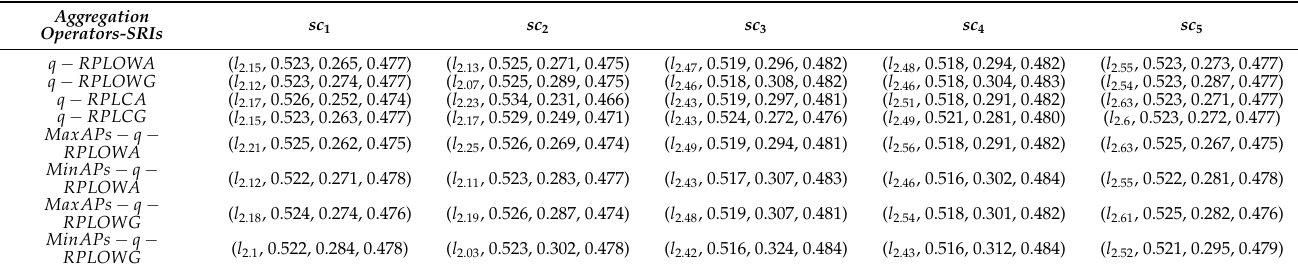
Table 9. The evaluations of SRIs by the q-RPL operators based on discrimination q-RPLNs matrix (Table 7). Aggregation Operators-SRIs sc 1